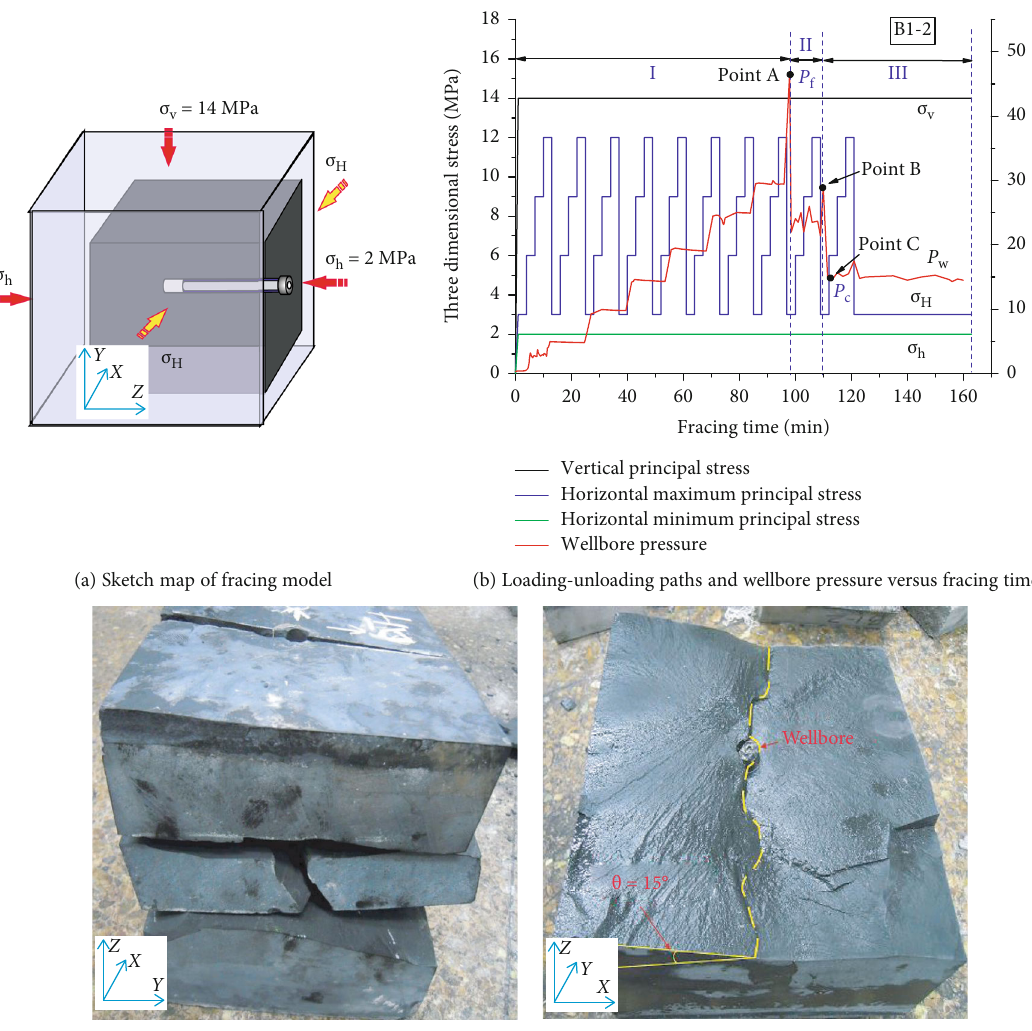
Figure 13: Loading-unloading paths and failure patterns for specimen